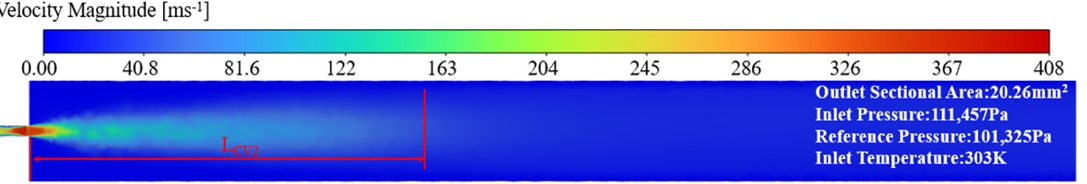
Figure 4. Turbulence velocity cloud map of the equal-diameter nozzle with a compressed air pres- sure of 212,782 Pa and a temperature of 303 K. of 212,782 Pa and a temperature of 303 K.